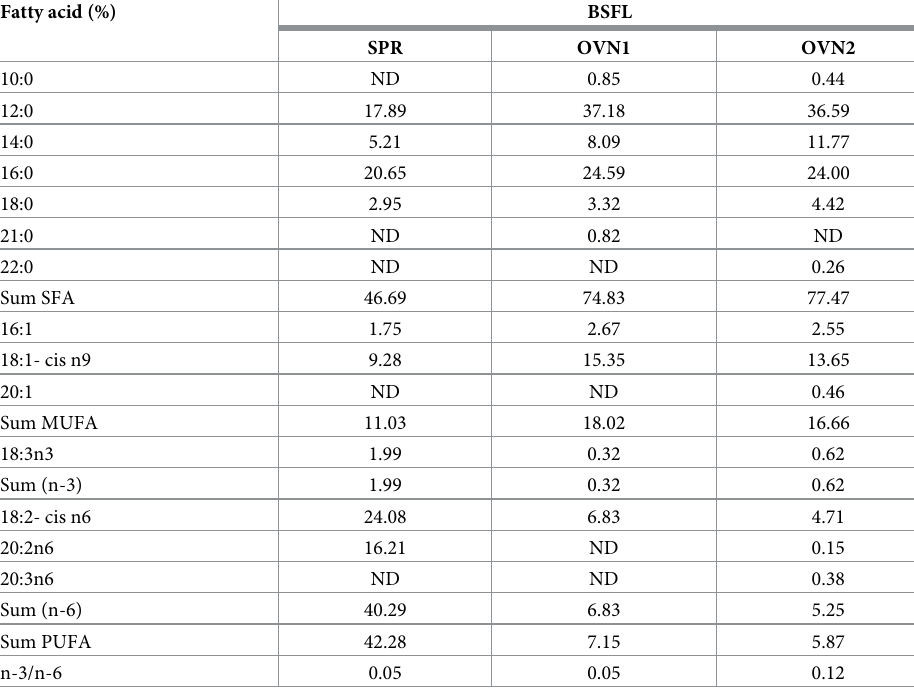
Table 3. Fatty acid composition (% of total fat) of the BSFL.